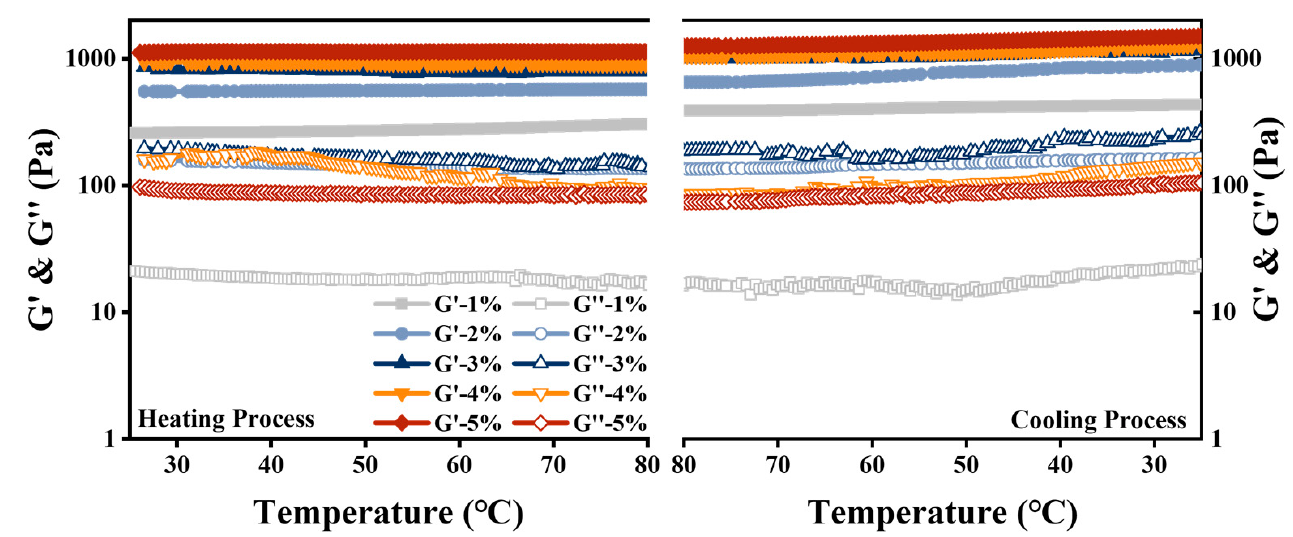
Figure 8. The response of storage modulus and loss modulus to temperature change of HIPEs stabilized by 1–5 wt% MPPI.